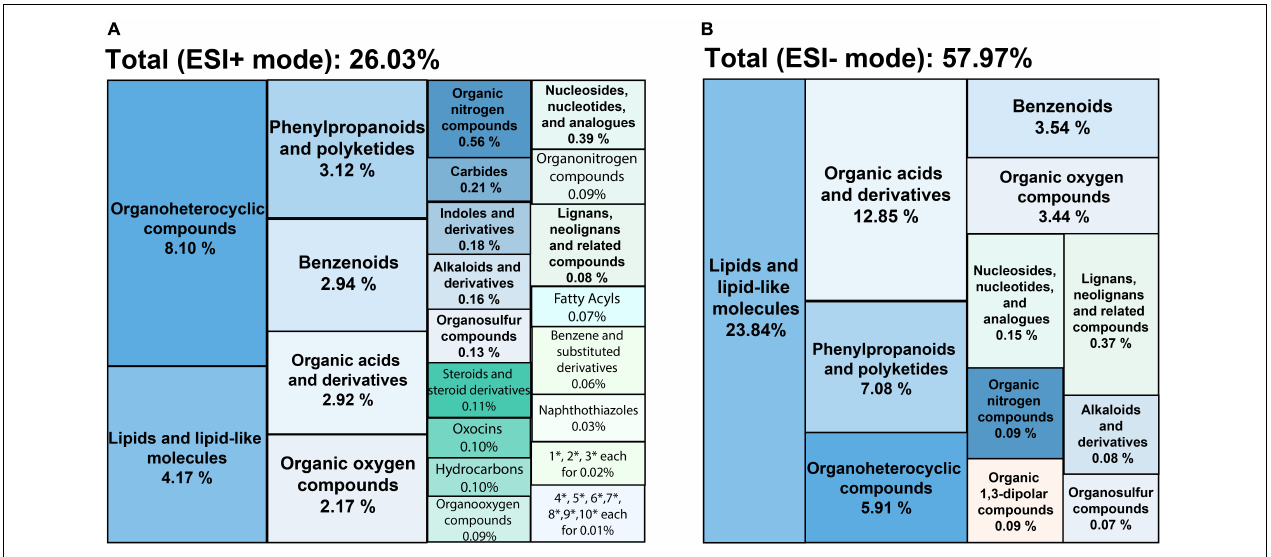
FIGURE 1 | Treemaps of chemical classifications of SBE compounds detected by UHPLC-PDA-HRMS in (A) ESI+ and (B) ESI– modes. Each color shows the chemical taxonomy at the superclass level from ChemOnt ontology. Each value indicates the relative distribution of each superclass by total peak areas. SBE, sunflower bark extract; ESI+ (–), positive (negative) electrospray ionization. Where ∗ is short for the superclasses following, 1: cinnamic acids and derivatives; 2: quinolines and derivatives; 3: imidazopyrimidines; 4: organic phosphoric acids and derivatives; 5: pyrroloazepines; 6: coumarins and derivatives; 7: pumiliotoxins, homopumiliotoxins, and allopumiliotoxins; 8: benzothiazoles; 9: azoles; 10: lupin